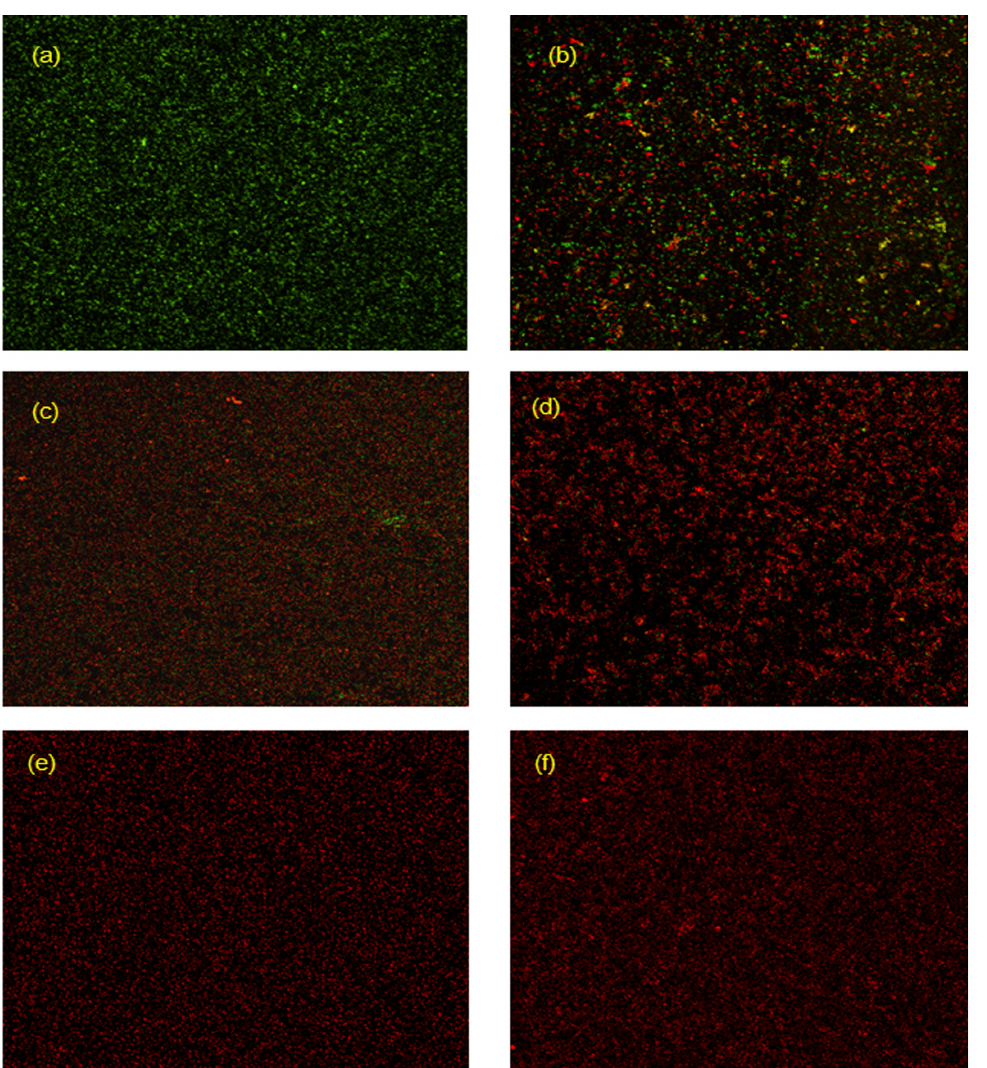
Fig 5. CLSM fluorescence microscopy images of (a) pristine Ti, (b) Ti-PTL, (c) LbL-CS/Ag10, (d) LbL-CS/Ag20, (e) LbL-CS/Ag50, (f) LbL-CS/Ag100 showing viability of the bacteria on samples after 7